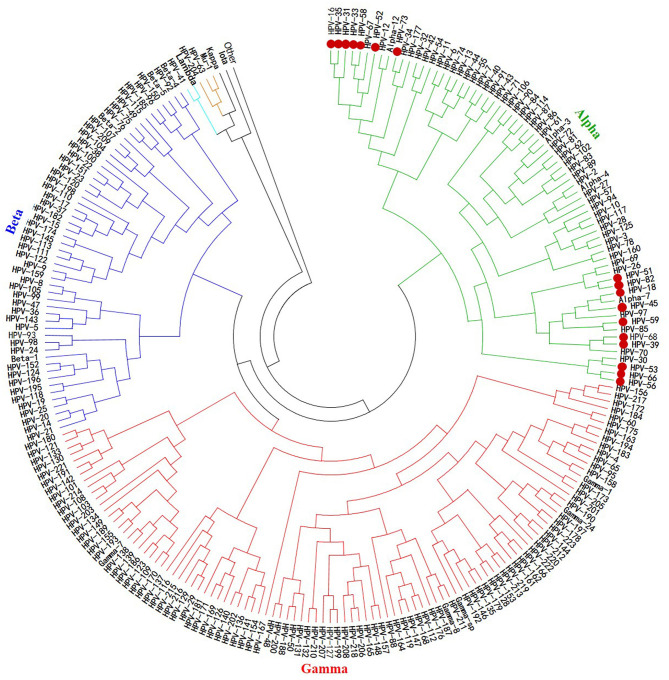
Phylogenetic tree of HPVs. The 200 HPV L1 protein sequences used to build this tree were retrieved from NCBI using the BLASTn tool, from an HPV L1 protein sequence blast. This phylogeny reconstruction was based on the neighbor-joining method with 500 bootstrap replications using MEGA7 software. It shows that all the oncogenic HPV types are clustered together within the same alpha gender. The actually considered 17 HR-HPVs are presented as bold red dots.